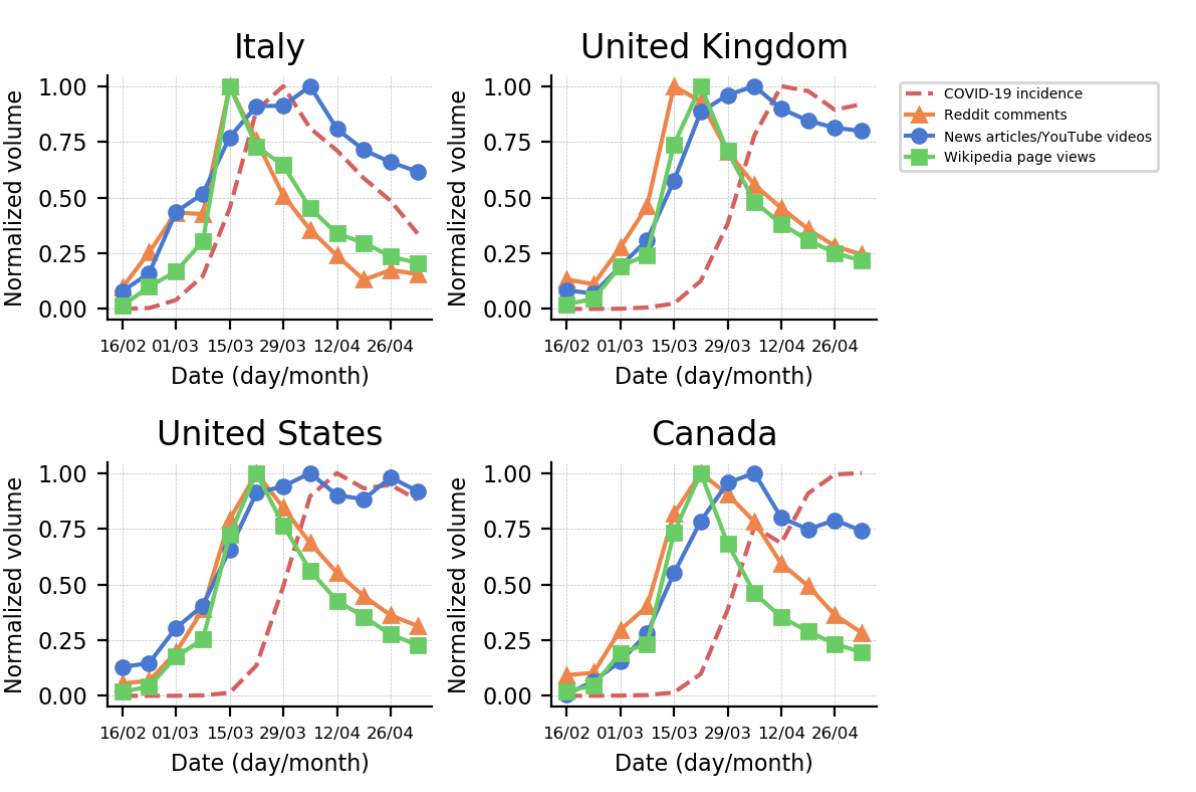
Figure 1. Normalized weekly volumes of news articles and YouTube videos, Reddit comments, and Wikipedia page views related to the COVID-19 pandemic and the incidence of COVID-19 in different